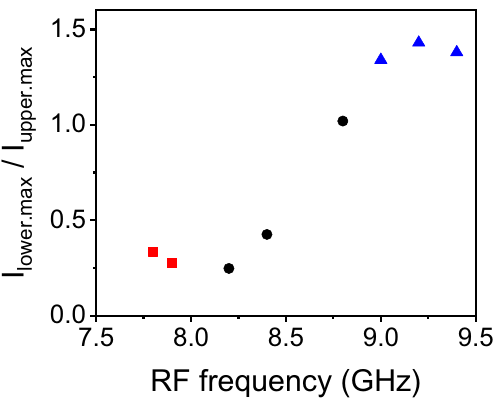
Figure 4. Intensity ratio (I lower.max /I upper.max ) of the Brillouin light scattering spectrum in Fig. 3, where I lower.max and I upper.max are the maximum intensities in the wider and narrower blocks, respectively. Red squares represent spin wave excitation only in the narrower block, blue triangles excitation only in the wider block and black circles excitation in both blocks.